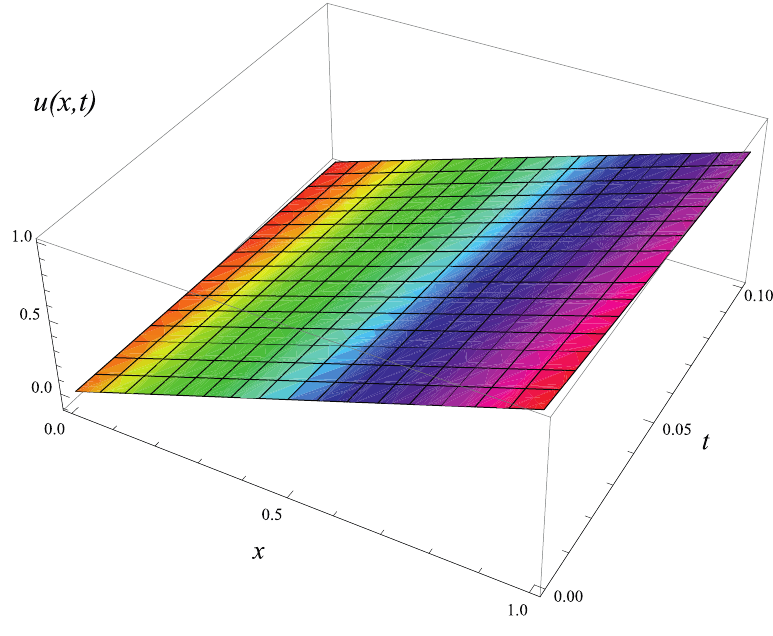
Figure 1. Plot of the exact solution u ( x , t ) .